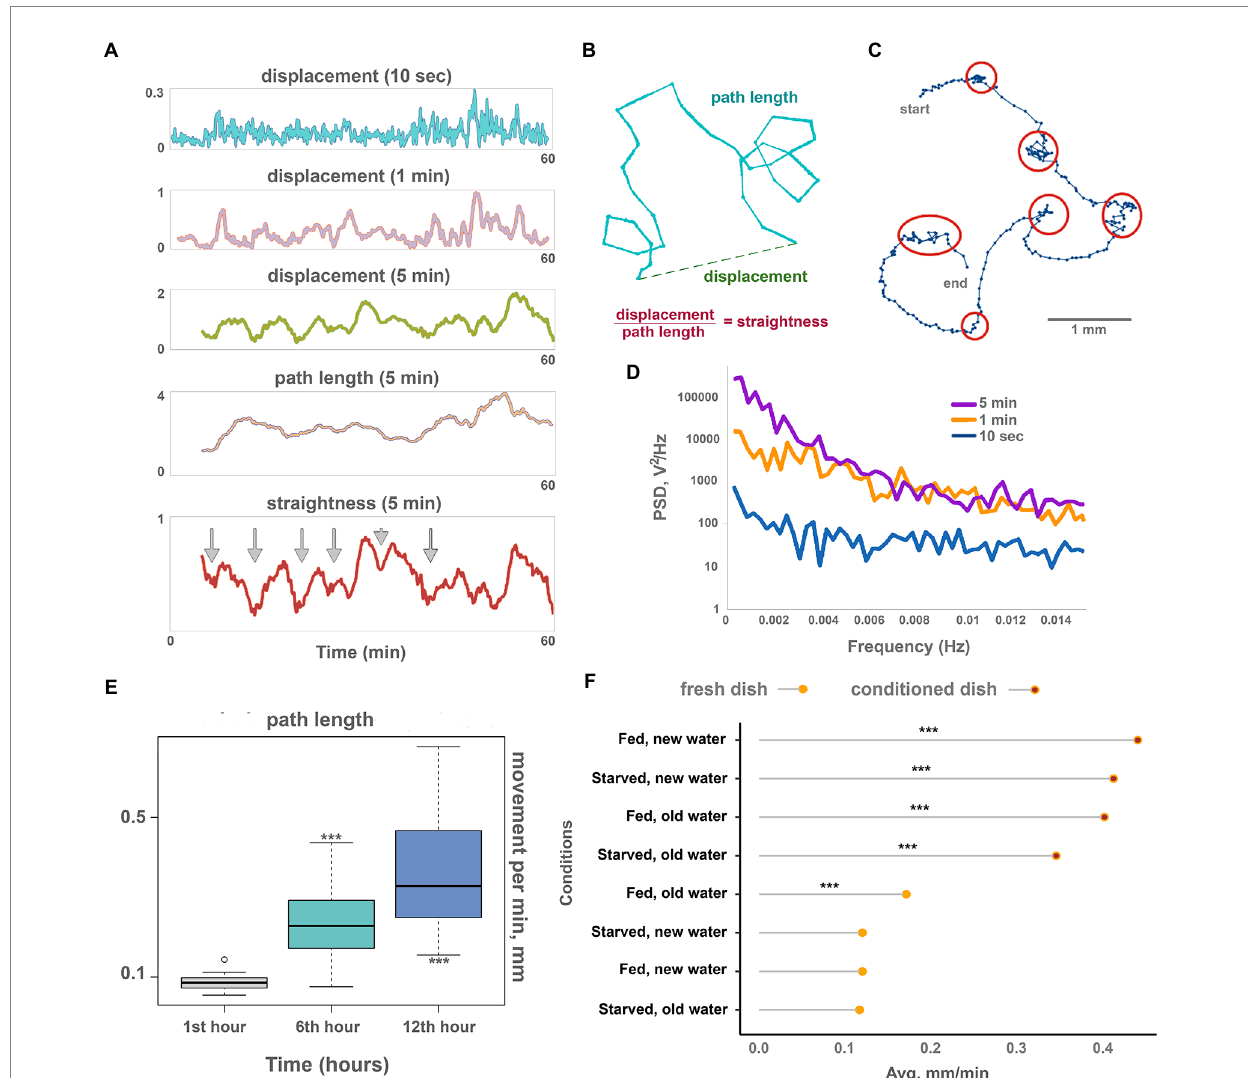
FIGURE 2 Oscillations and long-term dynamics during normal locomotion. (A) The plot of displacements (how far out of starting place an animal is located) of a single animal for 10 s, 1 min, and 5 min periods, plus track length and track straightness (displacement/length ratio) for 5 min periods observed for 60 min on conditioned Petri dish. While 10-s displacements are chaotic, oscillations emerge in 1 min and are clearly observed in 5 min displacements. Larger scale oscillations of 5 min displacement with a period of about 6–8 min coincide with fluctuations of path straightness. The path length is more stable over time and does not show regular oscillations. Arrows denote chaotic “marking time” periods every 6–8 min when track straightness is reduced. (B) Scheme showing displacement (how far out of an animal’s starting position), path length, and straightness. (C) Track of the Trichoplax with dots marking an animal’s positions every 10 s, recorded for 40 min—it is the same specimen as in A . Six periods of decreased locomotory speed (dense dots) are highlighted with red circles and correspond to straightness minima marked by arrows in A . Note that periods of decreased speed coincide with sharp turns of the track. See also Supplementary Videos S3. Animal size is about 0.5 mm. (D) Plot of power spectral density (PSD) of 10 s, 1 min, and 5 min displacements on conditioned Petri dish (average of 10 animals). PSD of 10-s displacements is nearly uniform (characteristic of white noise), while PSD of 1 min and especially 5 min displacements show pronounced low-frequency fluctuations (below 0.004 Hz, or periods above 250 s). (E) The speed of locomotion of the Trichoplax is gradually accelerated over 12 h. Animal locomotion and tracks were recorded at 60-min intervals. Asterisks denote significant differences in the locomotion speed from initial observations during the 1st hour (Welch t -test, *** p < 0.001) N animals = 20. (F) Factors affecting the long-term acceleration of Trichoplax adhaerens on glass dish: animal starvation, water, and glass freshness. Data are presented as median ± SD. N = 33, 36, 37, 34, 32, 35, 33, 35. Locomotion is slow on a fresh glass dish and accelerated on the conditioned (“old”) glass where placozoans (same or another specimen) crawled for 24 h before. The speed of locomotion was recorded for 120 min. Asterisks denote a significant difference in speed from the control condition (new dish, new water, well-fed animals; Welch t -test, *** p <